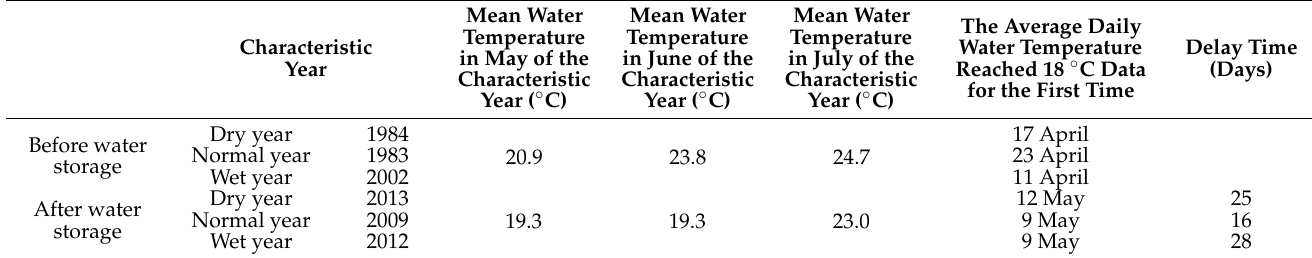
Table 6. “The four major fish species” breeding